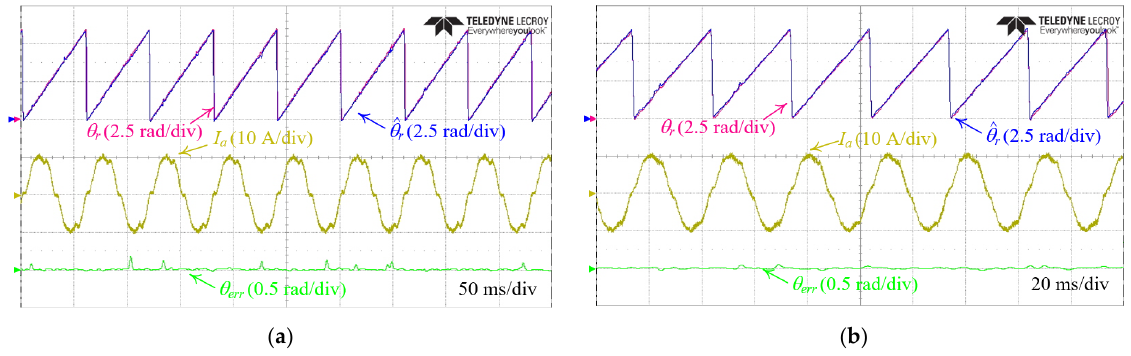
Figure 19. Magnified experimental results of the proposed flying start method at 500 rpm and 1000 rpm. ( a ) θ r , ˆ θ r , I a , and θ err at 500 rpm and ( b ) θ r , ˆ θ r , I a , and θ err at 1000 rpm.